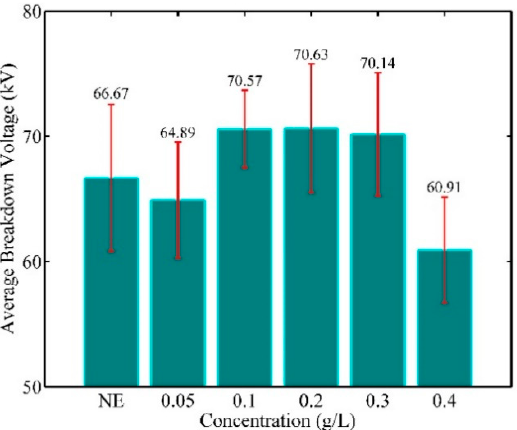
Figure 3. Average breakdown voltages of NE and ZnO nanofluids for different concentrations. Histogram charts of NE and nanofluids are given in Figure 4. These charts include breakdown frequency at different voltage levels, mean value of breakdown voltage and standard deviation. In terms of average breakdown voltage, 0.1, 0.2 and 0.3 g/L ZnO NFs perform better than NE.